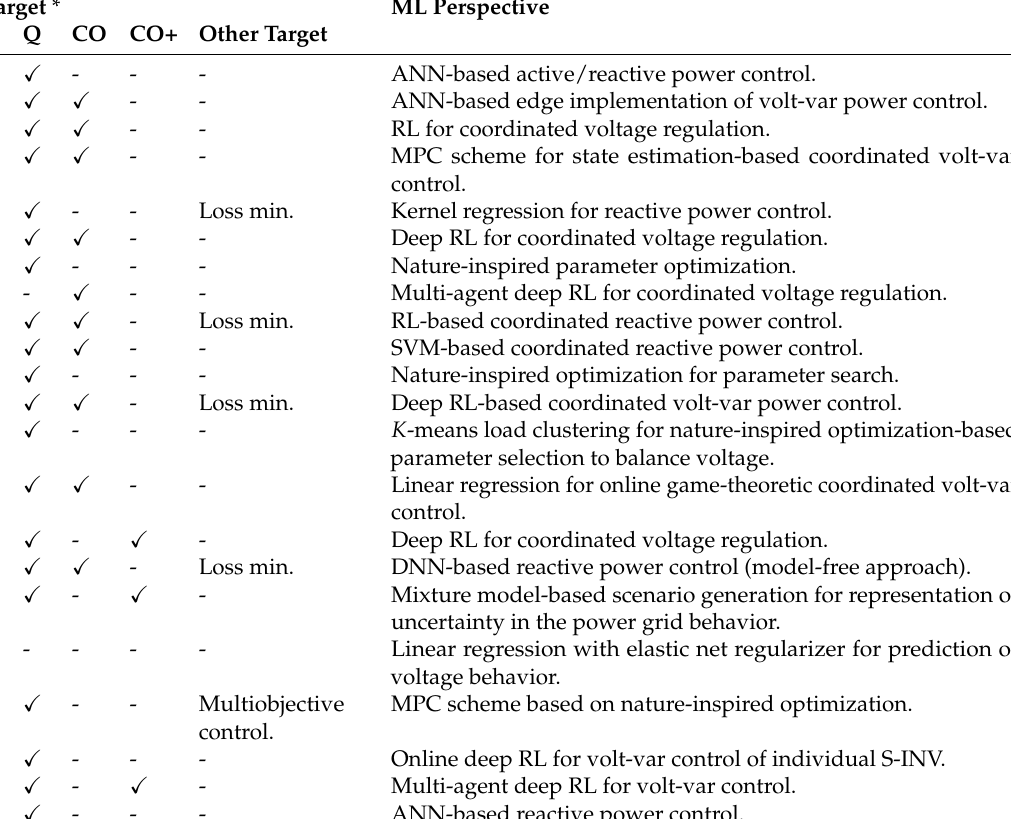
Table 4. Relevant studies on ML-based voltage regulation. Refs.